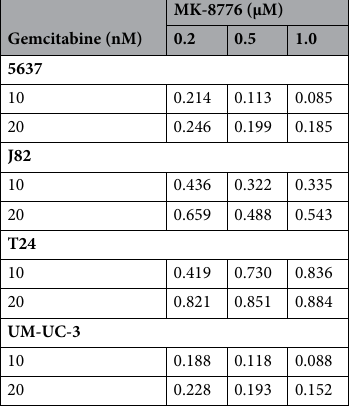
Table 1. Combination indices. Cell viability was used to calculate combination indices (CI) for each investigated cell line using the Chou–Talalay method to determine synergistic effects (CI < 1 indicates